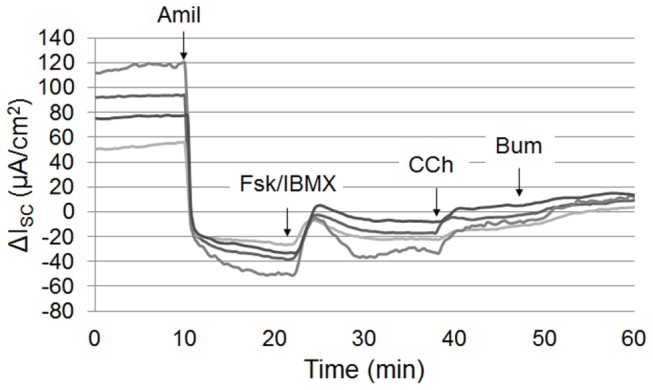
Partial CFTR function detected in F508del/F508del CF subject.Representative tracing from an F508del/F508del subject with functional F508del CFTR. Adding forskolin/IBMX to raise cAMP increased the current > 30µA/cm2 which was further augmented by carbachol.